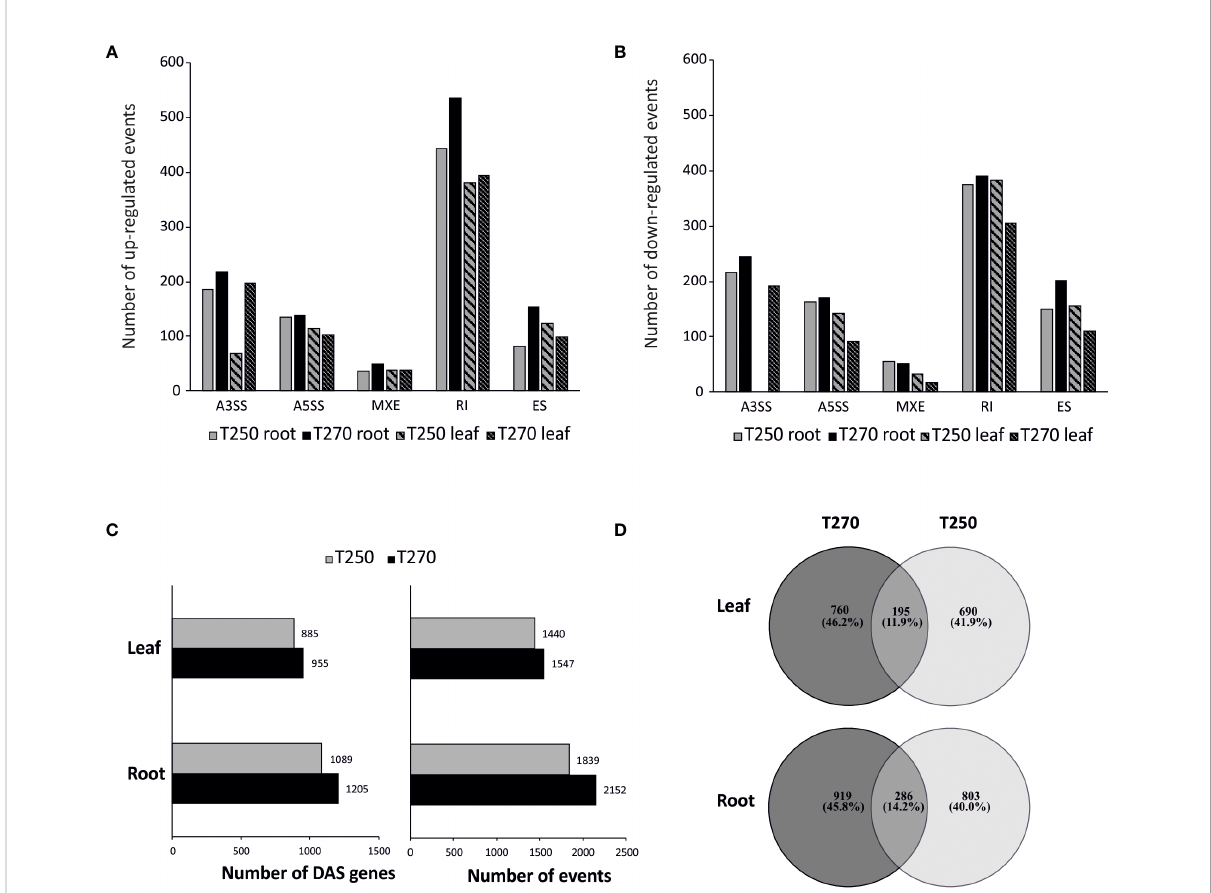
FIGURE 6 Alternative splicing (AS) regulation in root and leaf of T250 and T270 under combined stress condition. (A, B) Bar graph of the number of differential up- (A) and down-regulated (B) AS events. (C) Number of genes concerned by DAS (left) and DAS events (right). (D) Venn diagram depicting the number of genotype-speci fi c and common (DAS)